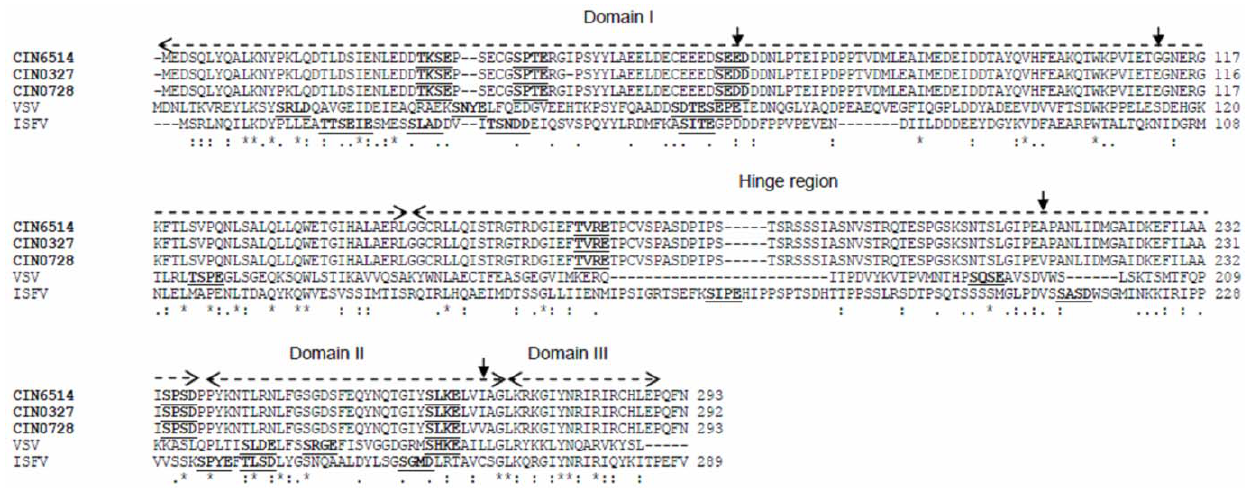
Figure 4. Alignment of P protein of representative CHPV isolates (indicated in bold) with closely related vesiculoviruses VSV and ISFV. All putative phosphorylation sites are underlined. The different domains defined for the P protein of VSV are indicated by two-headed dashed overhead arrows. The mutations within the CHPV isolates are indicated by downward arrows.